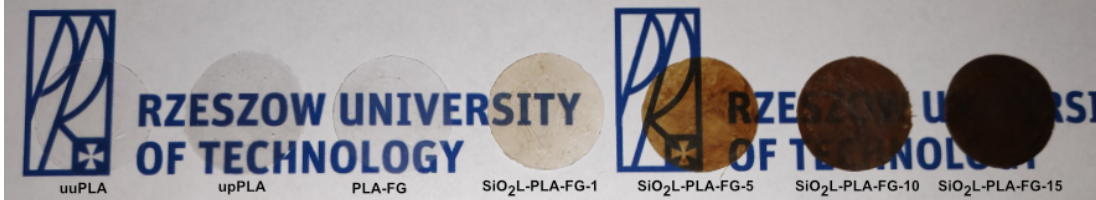
Figure 3. Visual apperance of SiO 2 -PLA-FG